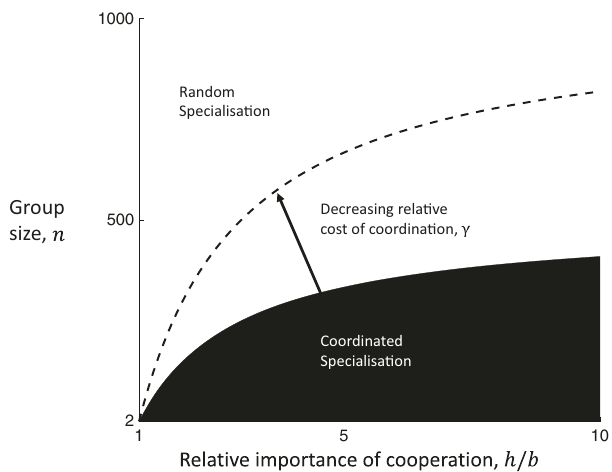
Fig. 3 Random versus coordinated specialisation. Small group sizes (lower n ), relatively more important cooperation (higher h = b ), and lower relative metabolic costs to coordination (lower γ ) favour division of labour by coordinated specialisation (black) over division of labour by random specialisation (white). This is a visual depiction of Condition 5. We have used γ ¼ 2 ´ 10 (cid:1) 3 (solid boundary) and γ ¼ 1 ´ 10 (cid:1) 3 (dashed boundary). We note that the limit as the relative importance of cooperation goes to in fi nity (very large h = b ) converges to the outcome for when cooperation is essential ( b ¼